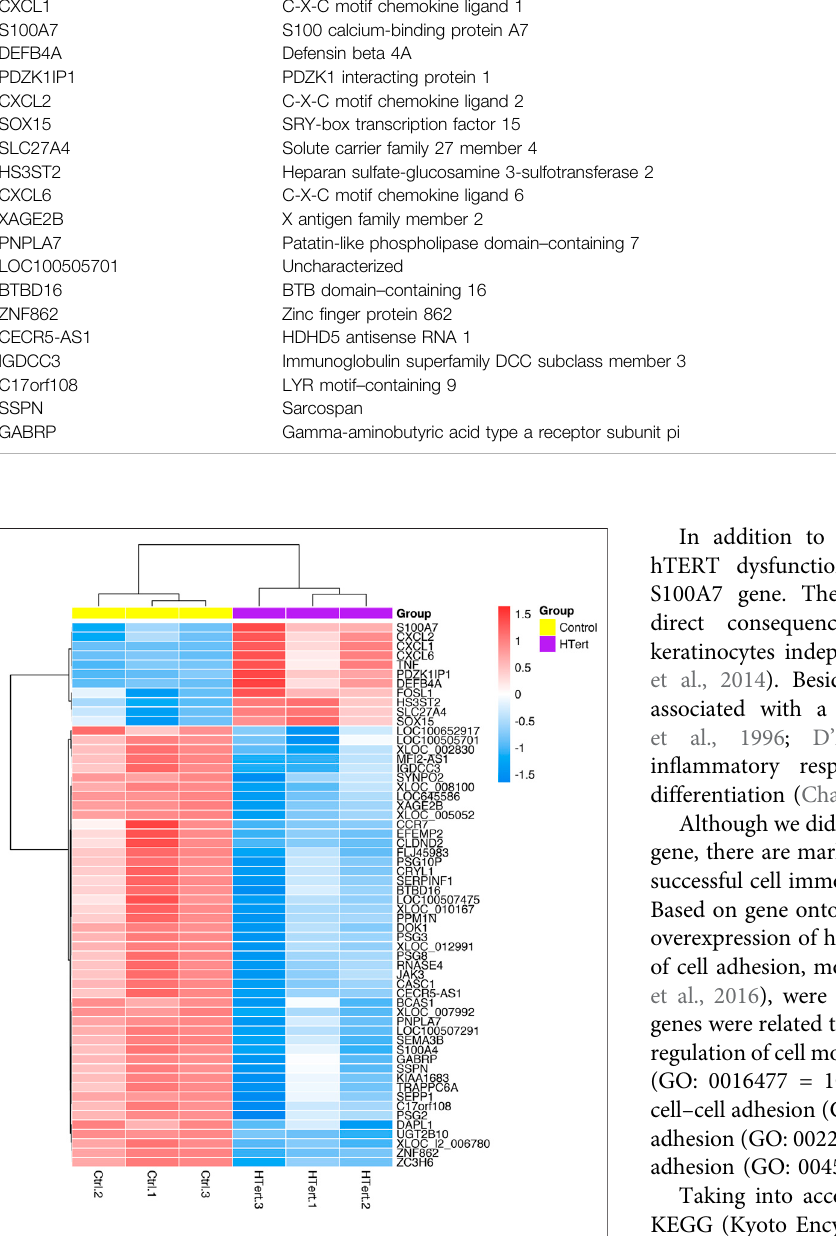
FIGURE 6 | Heatmap of differentially expressed genes in hPLF after the immortalization process (control vs. hTERT). The dendrograms represent the hierarchical cluster relationship between genes (left side) and among samples (upper), based on Pearson ’ s correlation; log2FC > 1 or < − 1. log2-fold change > 1.5 or < − 1.5; adj.; cut-off adj. p -value: <